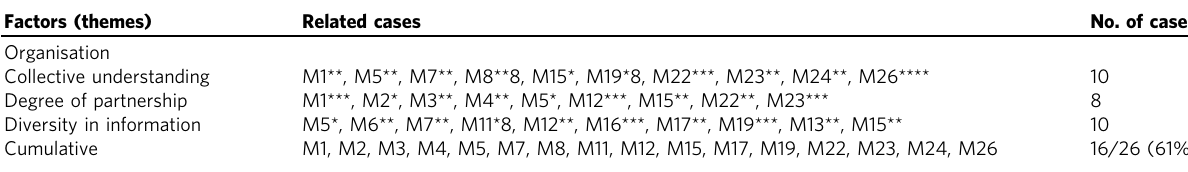
Table 6 Organisational factors and supported cases.